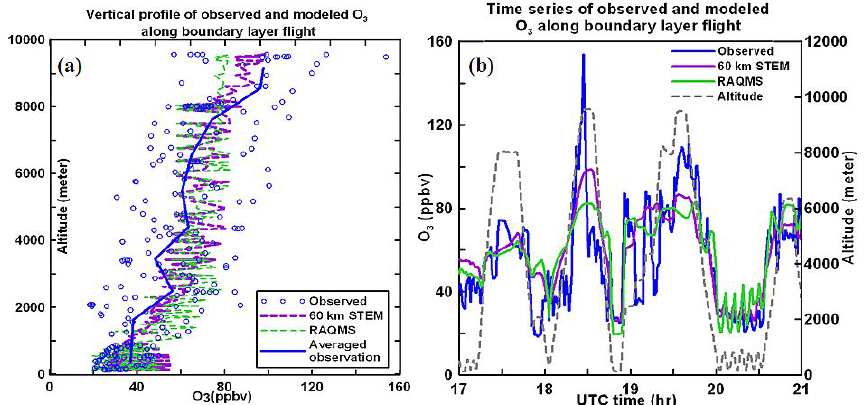
Fig. 13. Observed and modeled (60km STEM and RAQMS) O 3 (a) vertical profiles and (b) time series plots along oceanic flight path. RAQMS and 60km STEM base results were used as the boundary conditions for 60km and 12km STEM base cases